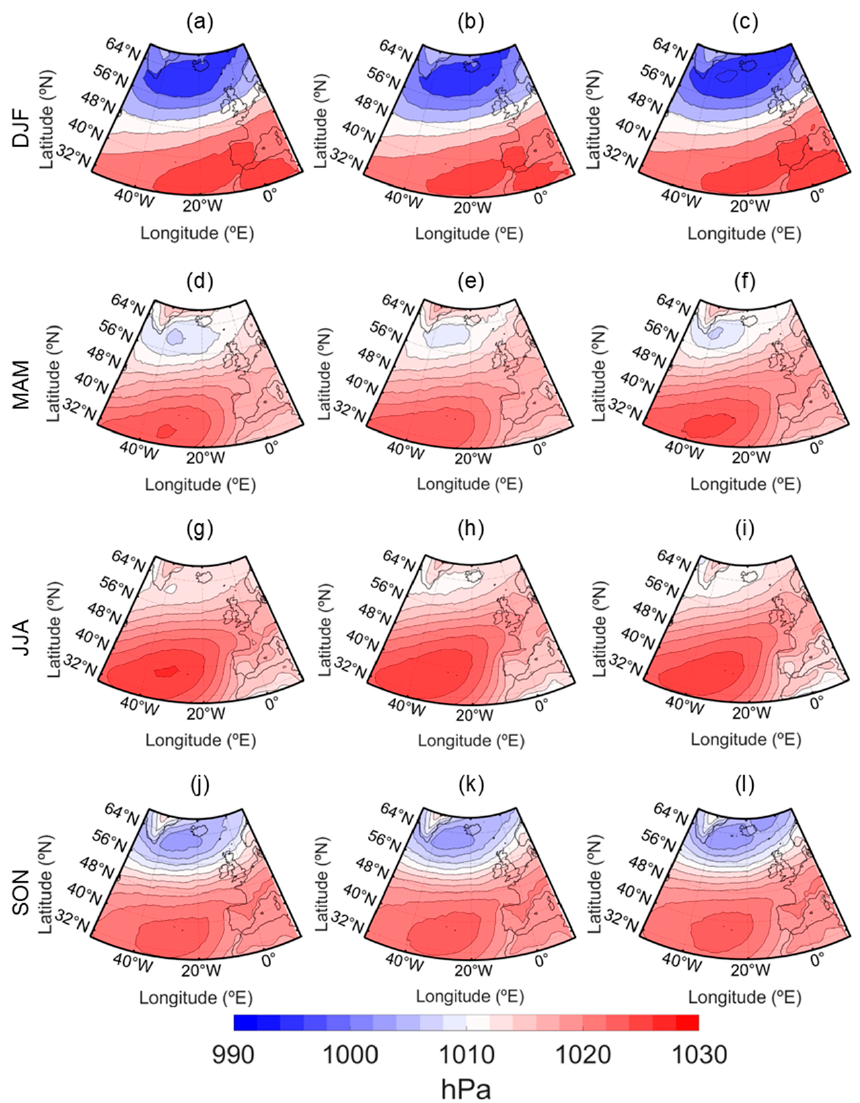
Figure 2. Seasonal (winter: DJF, spring: MAM, summer: JJA, and autumn: SON) medians of SLP (hPa) for the reference period (1995–2014, left column ( a , d , g , j )) and future periods (2046–2065, middle column ( b , e , h , k ); 2081–2100, right column ( c , f , i , l )), under SSP5-8.5.